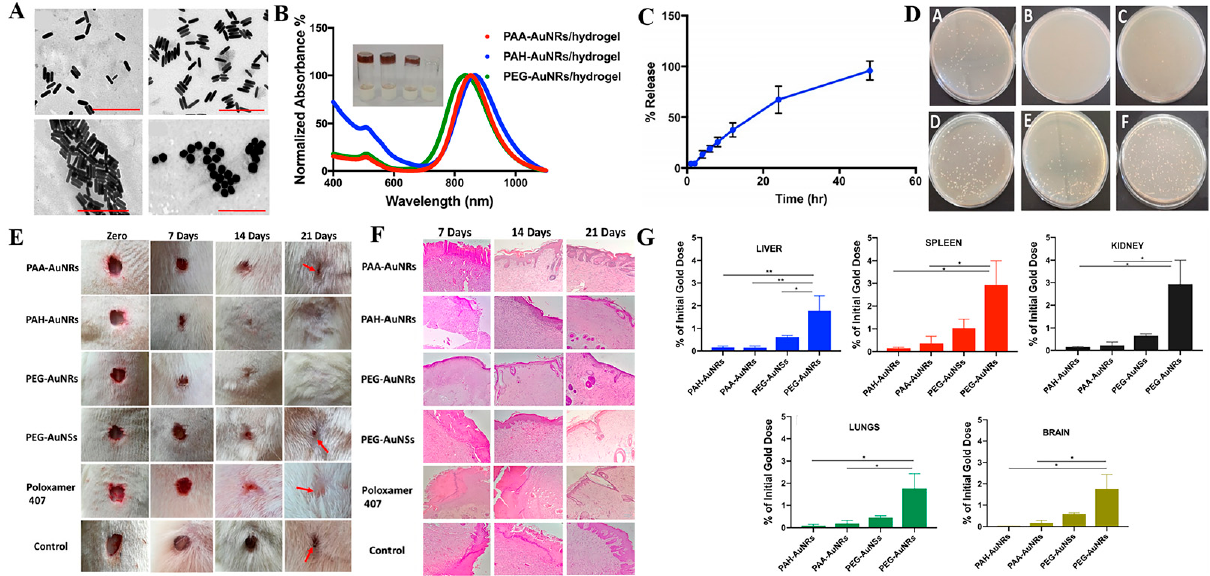
6 of 30 Figure 2. ( A ) Schematic representation of the preparation process and possible self-assembly mech- anism of Ag@Ligin NPs-loaded hyaluronic acid (HA) nanocomposite hydrogel. Profile of the hy- drogel’s antibacterial activities against ( B ) Staphylococcus aureus and ( C ) Pseudomonas aeruginosa . ( D ) Viability of keratinocytes after 1, 3 and 7 days coculture with the Ag@Lig NPs-loaded hydrogel. ( E ) Representative images of full-thickness skin wounds in a mouse model before and after application of the nano-enabled hydrogels. ( F ) Hematoxylin-eosin-stained sections of wound tissues across dif- ferent treatments. Reproduced with permission from ref [59], Copyright 2021 Elsevier . Gold nanoparticles (AuNPs). Apart from AgNPs, AuNPs have also been extensively applied in infection therapy, wound healing, and tissue regeneration due to their excellent biocompatibility, good optical and chemical stability as well as ease of surface modifica- tion [42,62–64]. AuNPs differ from AgNPs in that they release Ag + which possess good bacteria-killing capability by directly targeting and destroying their cell walls to cause loss of intracellular components, inhibit ATP synthesis and interfere with DNA transcription. Studies have demonstrated that AuNPs exert broad-spectrum antibacterial activity against both Gram-negative and Gram-positive bacteria, including E. coli , P. aeruginosa , S. aureus , and MRSA [63,64]. AuNPs can also efficiently absorb near infrared light and con- vert it into heat, which further endows them with the photothermal bactericidal ability [65]. Moreover, AuNPs act as antioxidants and have been shown to promote wound repair by regulating anti-inflammatory cytokines, suppressing ROS levels and promoting angi- ogenesis [66,67]. However, using AuNPs alone at the wound site is constrained by rapid loss and the associated toxic side effects. Consequently, researchers have integrated AuNPs into a wide range of hydrogel wound dressings with the aim of improving their efficacy and reducing the associated side effect [68,69]. For example, AuNPs with different shapes (nanorods and nanospheres) and surface modifications (neutral, positive and neg-